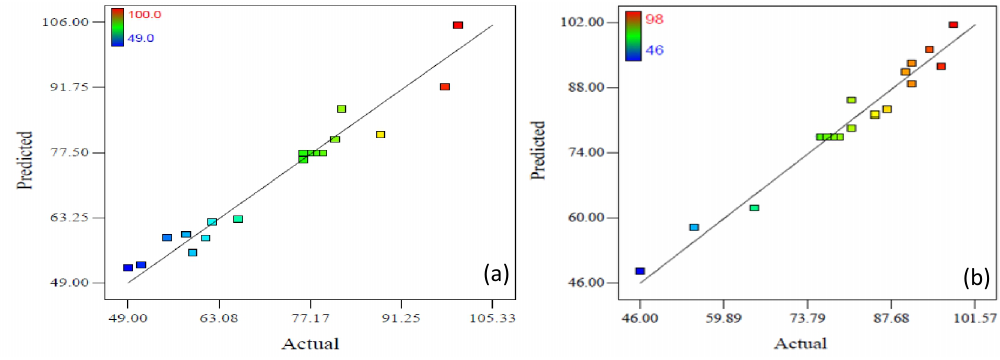
Fig. 2. Actual values vs. predicted values for (a) Fe recovery and (b) Cu recovery